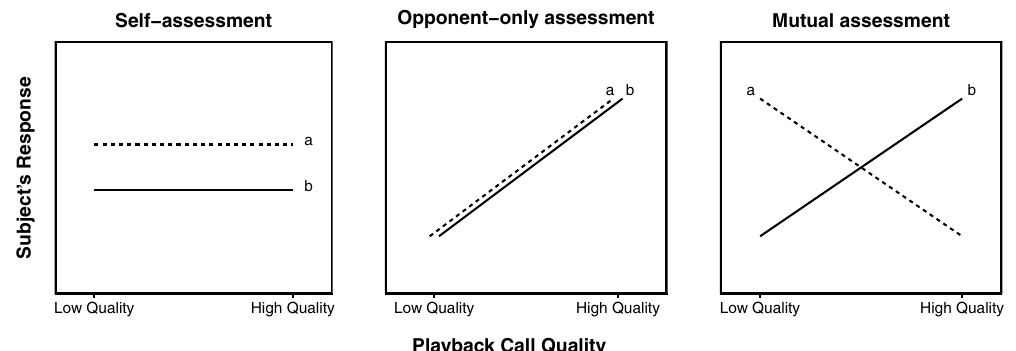
Figure 1. Predictions for bachelor male ( a ) and leader male ( b ) responses to low- and high-quality simulated loud calls for three assessment strategies: self-assessment, opponent-only assessment, and mutual assessment.